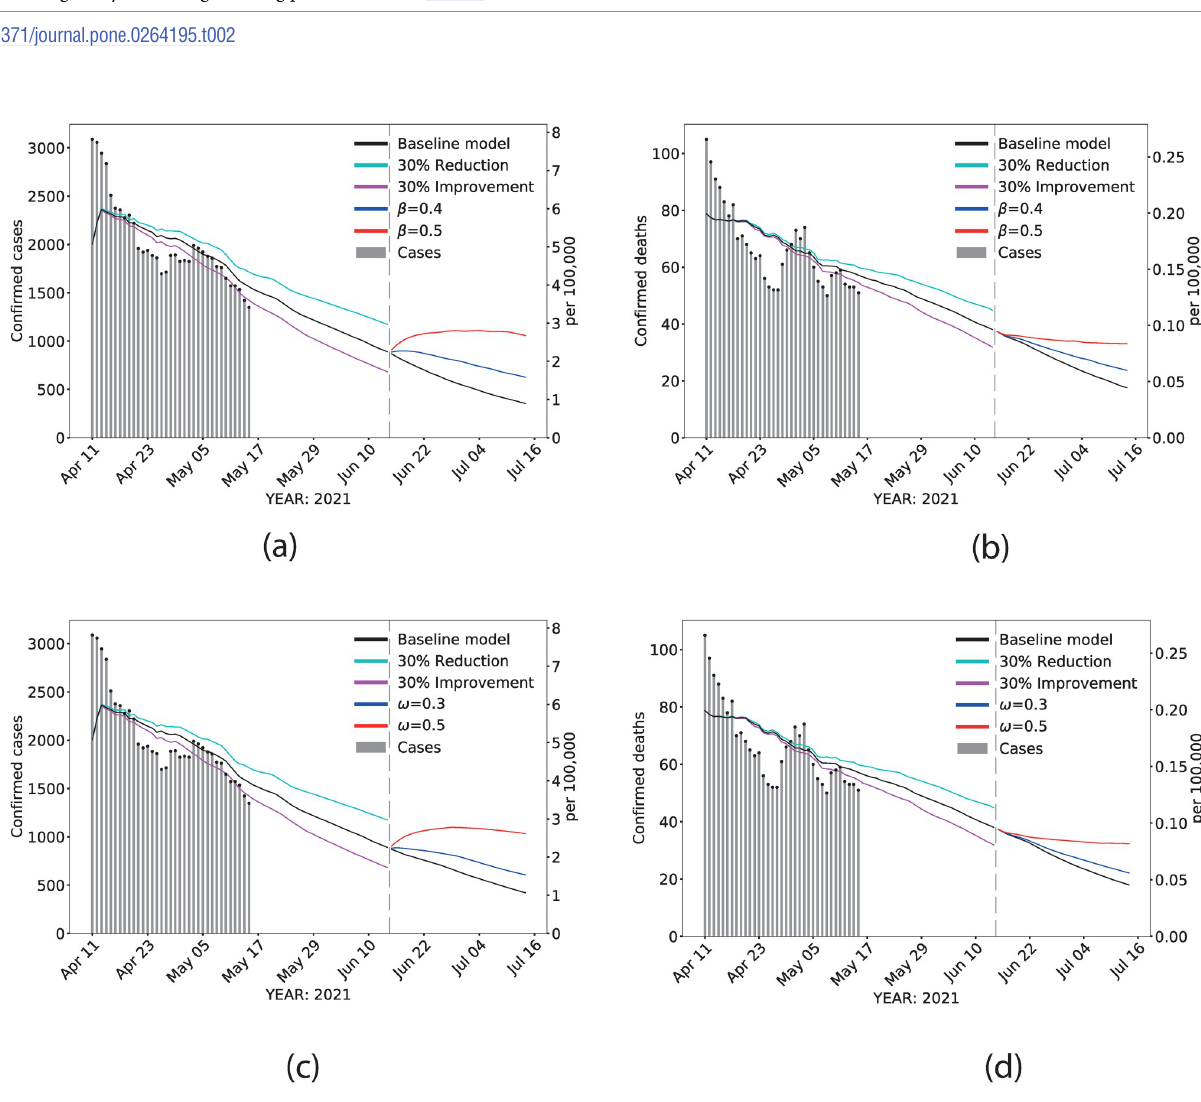
Fig 2. Scenarios. Estimated statewide confirmed cases and confirmed deaths during live data collection, extrapolated between May 18th and June 15th for different vaccination rates, and predicted beyond June 15th with different effective population proportions and transmission rates. (A) and (B): effects of varying transmission rate on confirmed cases and confirmed deaths, respectively. (C) and (D): effects of varying the effective population proportion on confirmed cases and confirmed deaths, respectively. Dashed vertical line: June 15th. Gray vertical bars: daily reported data. Black line: baseline scenario, before and after opening. Cyan line: projection from May 18th assuming a 30% reduction in the current vaccination rate. Magenta line: projection from May 18th assuming a 30% increase in the current vaccination rate. The values used for β = 0.4, 0.5, and ω = 0.3, 0.5 were selected according to historical data in CA (see S6 Fig in S1 File).